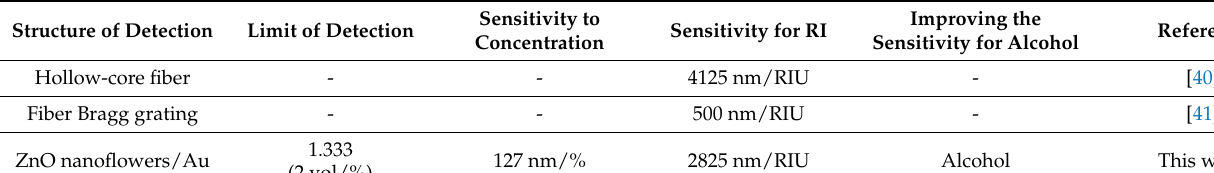
Table 2. Comparison of performance of three sensors.